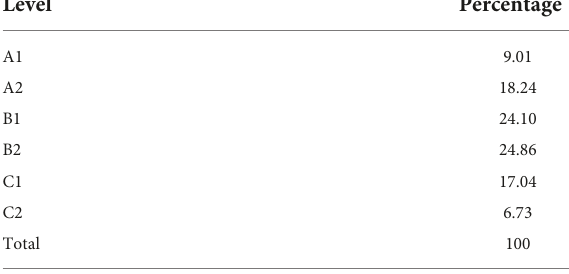
TABLE 1 Evaluation of the area of information and information knowledge.